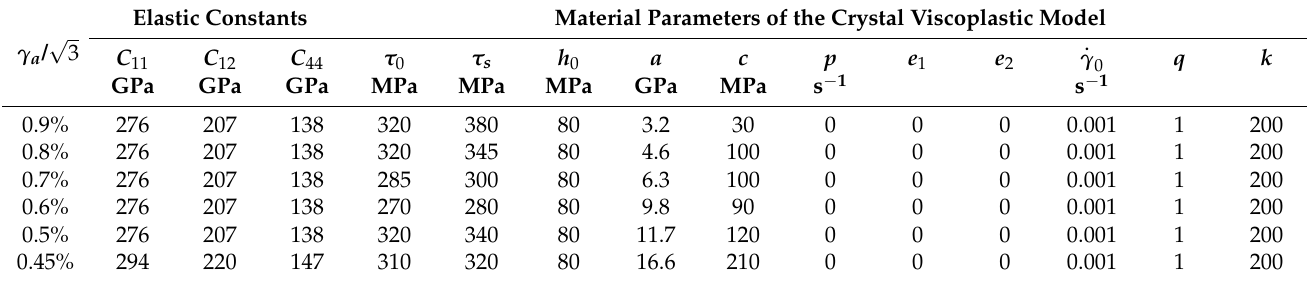
Table 3. Elastic constants and crystal plasticity parameters of 30CrMnSiNi2A at different shear amplitude. Elastic Constants Material Parameters of the Crystal Viscoplastic √ γ a / 3